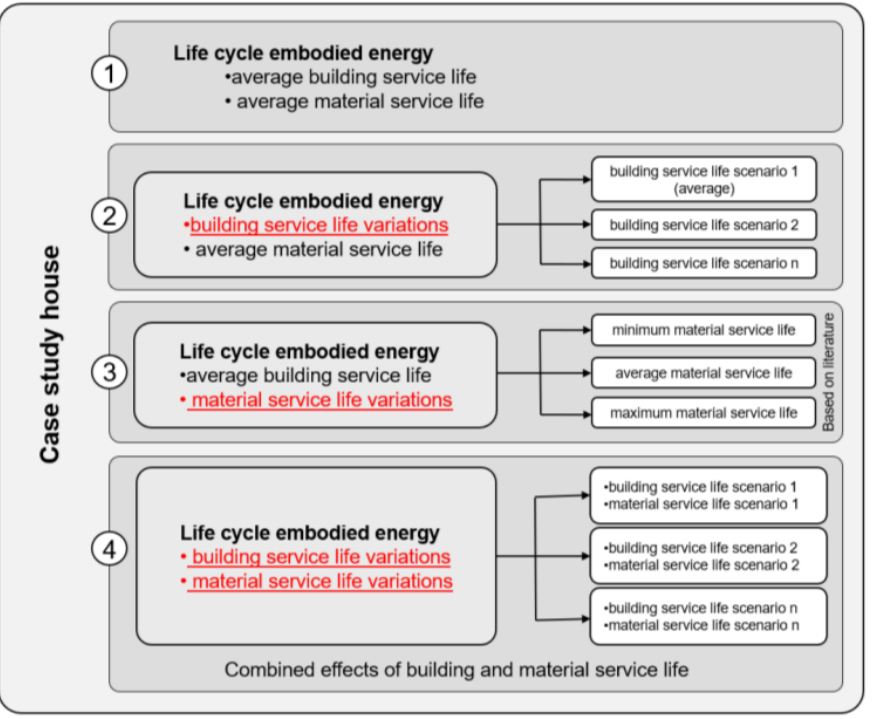
Figure 1. Steps taken during the research (adapted from [36]).